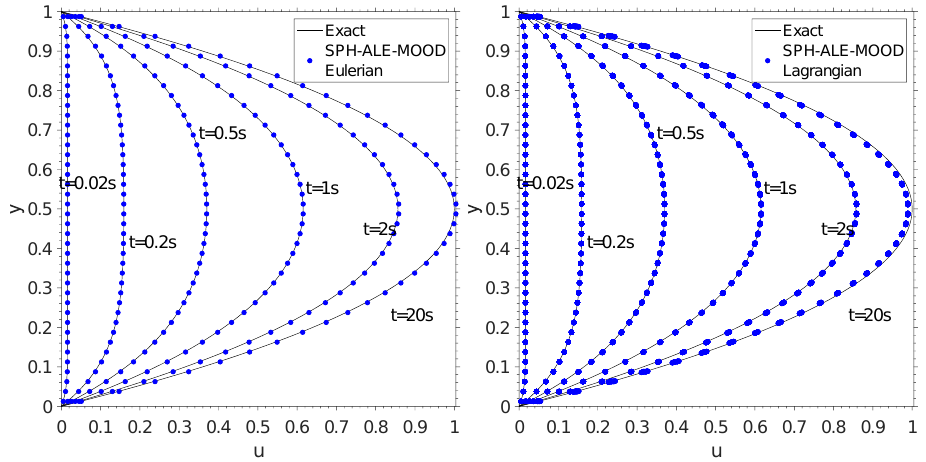
Figure 17. Time evolution of the velocity profile for the Poiseuille flow Re = 10 with Eulerian ( left ) and Lagrangian description ( right ). The numerical solution is compared with the exact solution presented in (18).